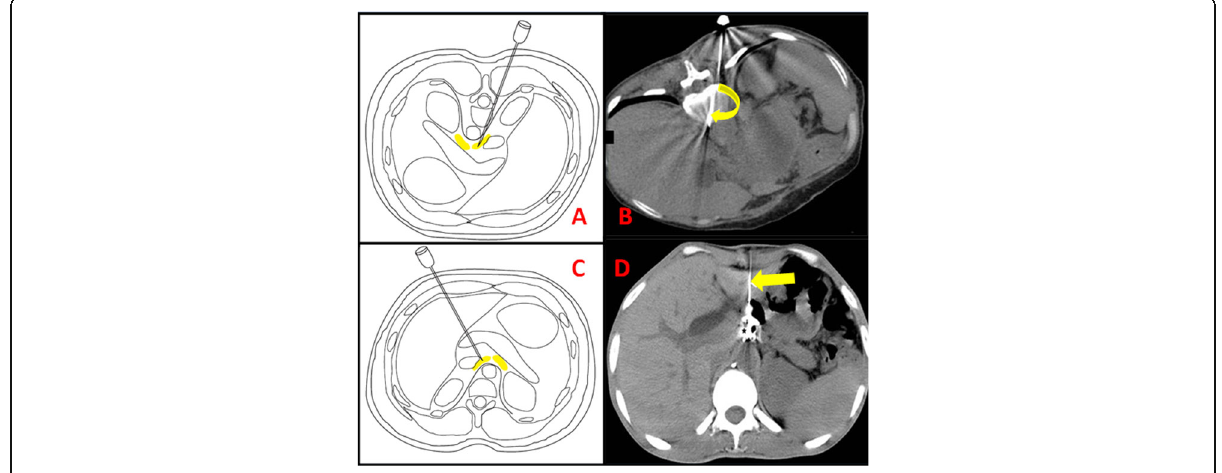
Fig. 6 Celiac plexus block. Schematic ( a ) and axial CT section ( b ) post-procedural needle tip (curved arrow) of transdiscal approach. Schematic ( c ) and CT section post-procedural free flow of contrast ( d ) of anterior transhepatic